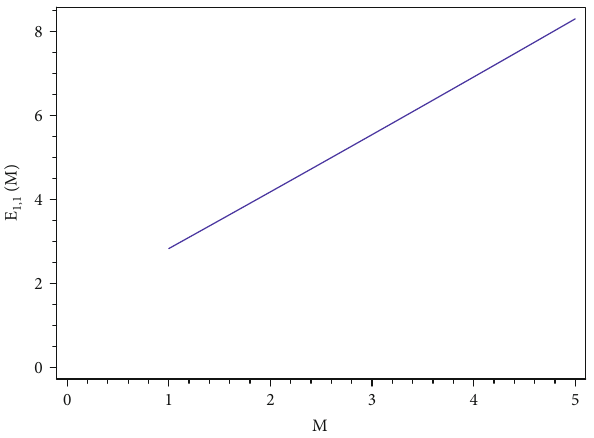
Figure 9: n = l = k = q = a = b = η